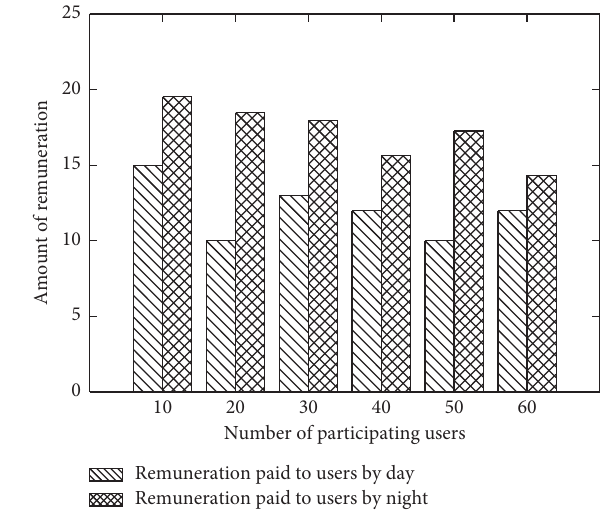
Figure 5: Amount of remuneration.